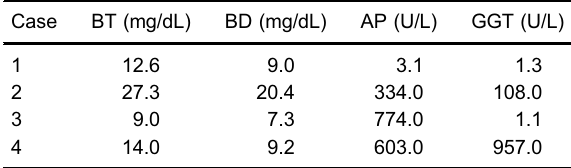
Table 1. Baseline biochemical